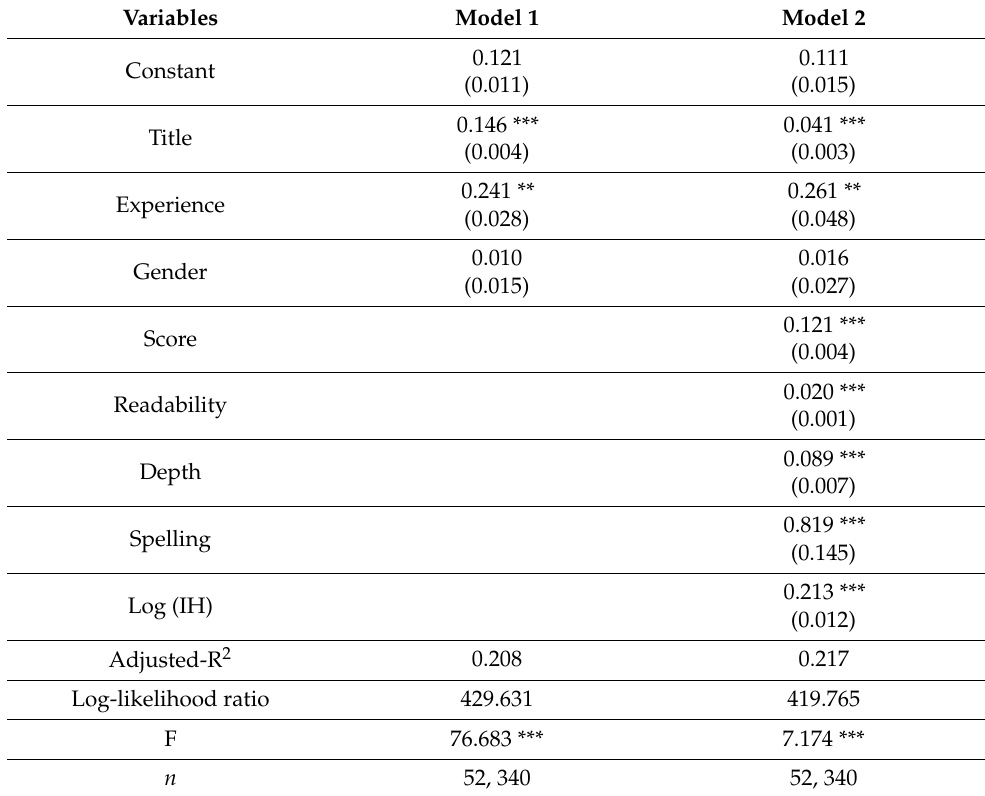
Table 3. Estimation